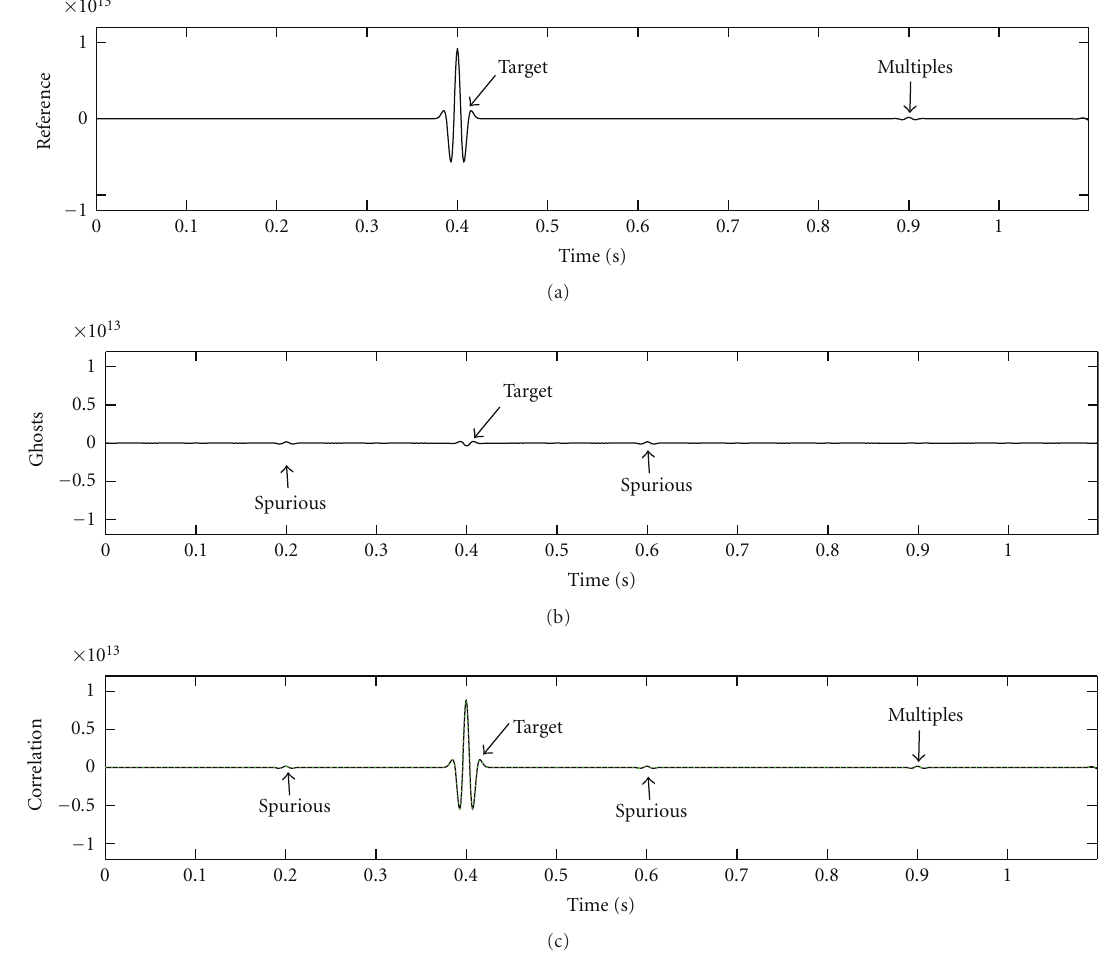
Figure 11: Cross-correlation of decomposed fields for model B: (a) reference response by placing an active source at the virtual source location x A ; (b) computed ghost terms g S